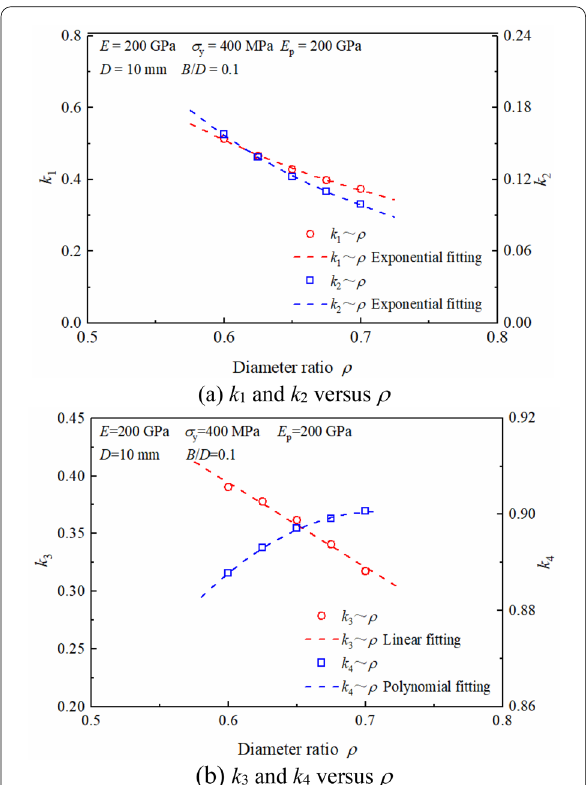
Figure 7 Fitting relations between k 1 to k 4 and ρ